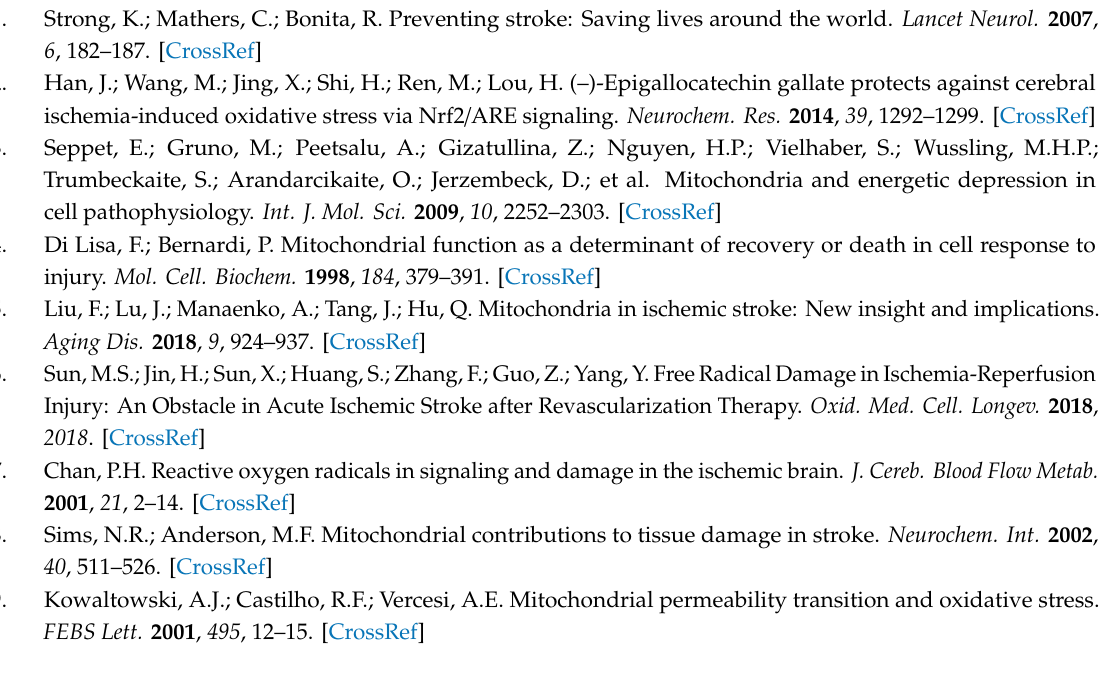
Figure S1: The e ff ect of hypoxia and deoxyglucose (DOG) on the number of chromatin-condensed nuclei ( a ) and caspase-3 activity level ( b ) in mixed neuronal-glial cultures; Figure S2: Average values of the mitochondrial oxygen consumption curves obtained by the Seahorse XFp